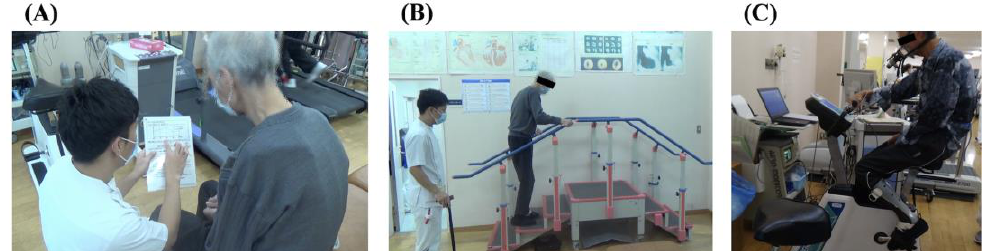
Figure 1. Preoperative rehabilitation. ( A ) Preoperative rehabilitation guidance was provided using